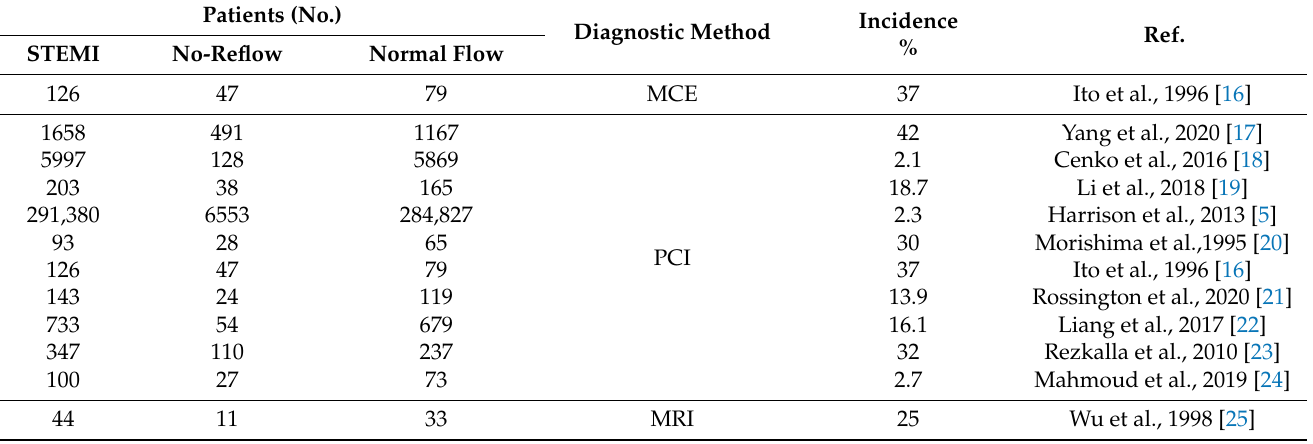
Table 1. The incidence rate ratio of the no-reflow